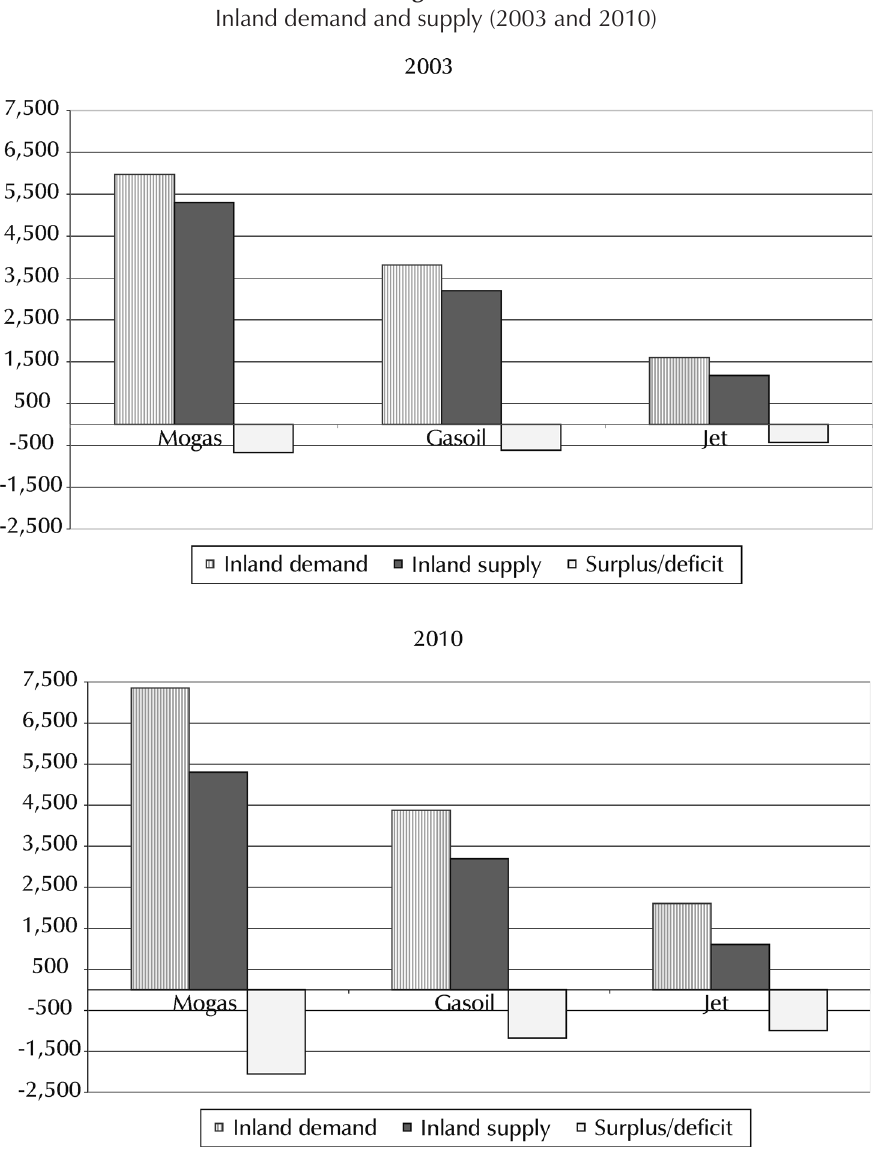
Inland demand and supply (2003 and